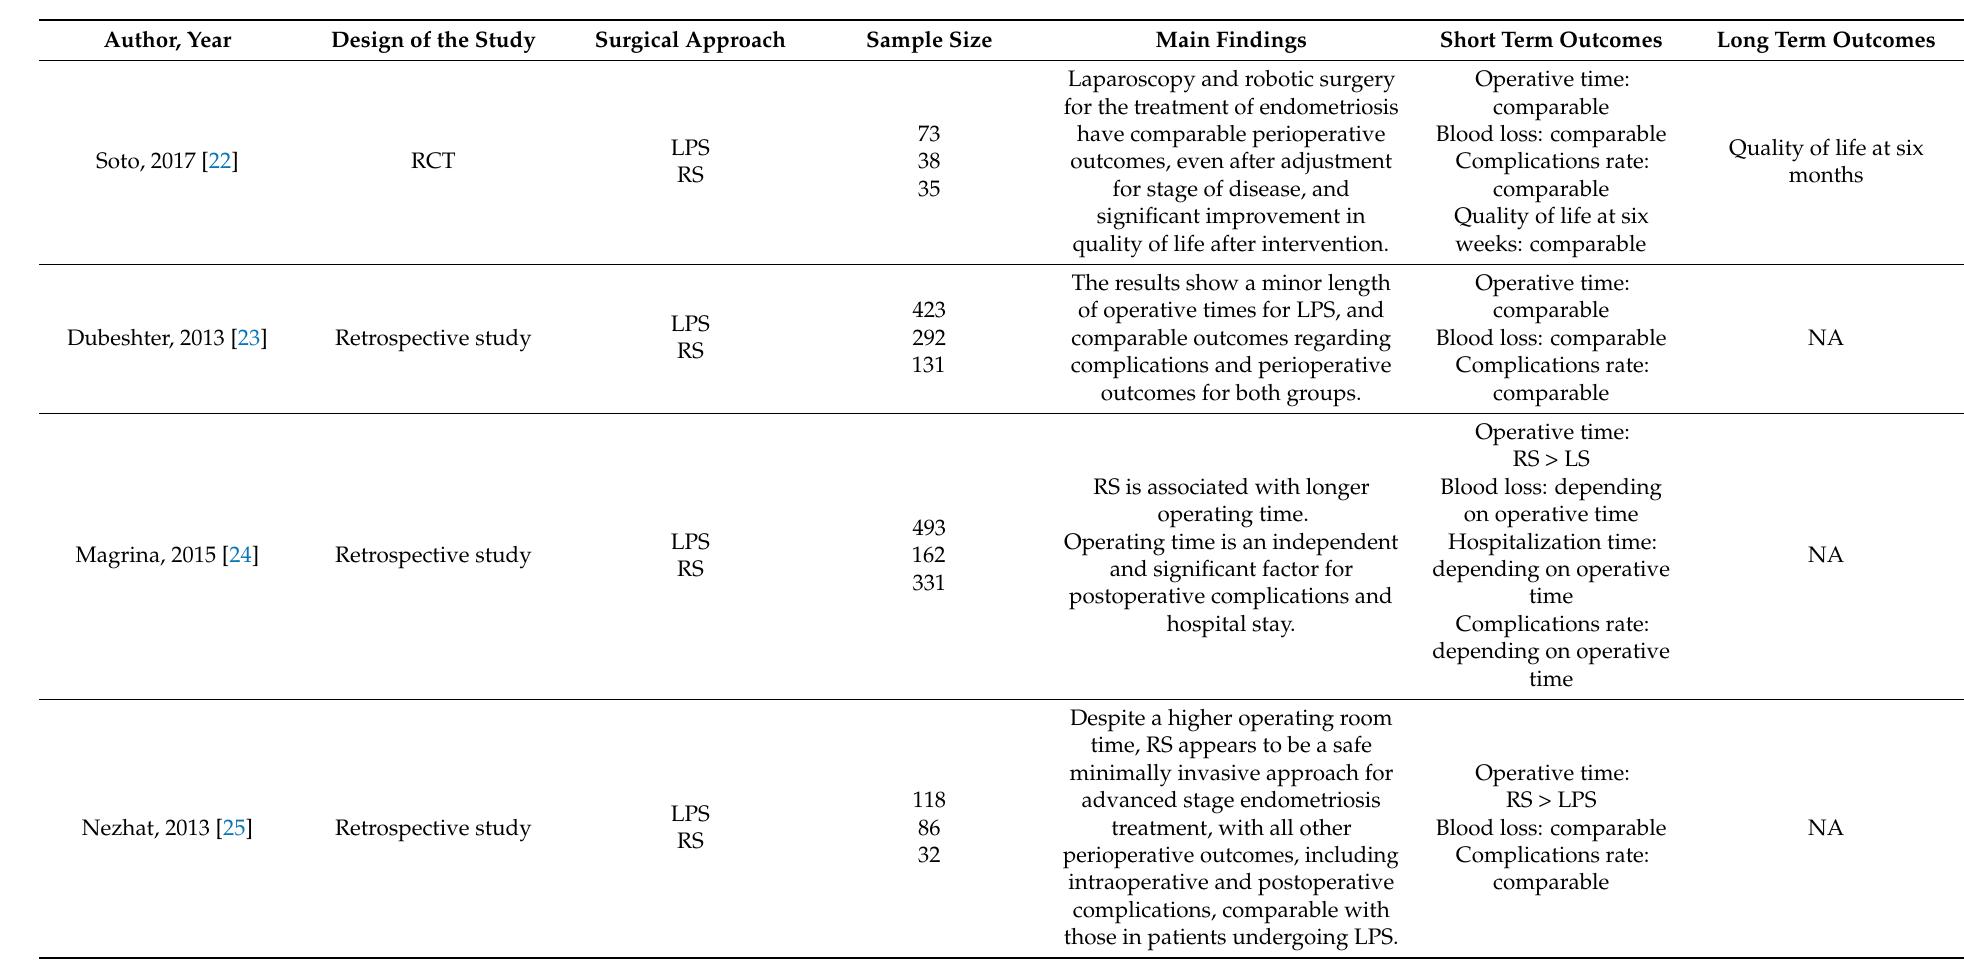
Table 3. Robotic endometriosis treatment